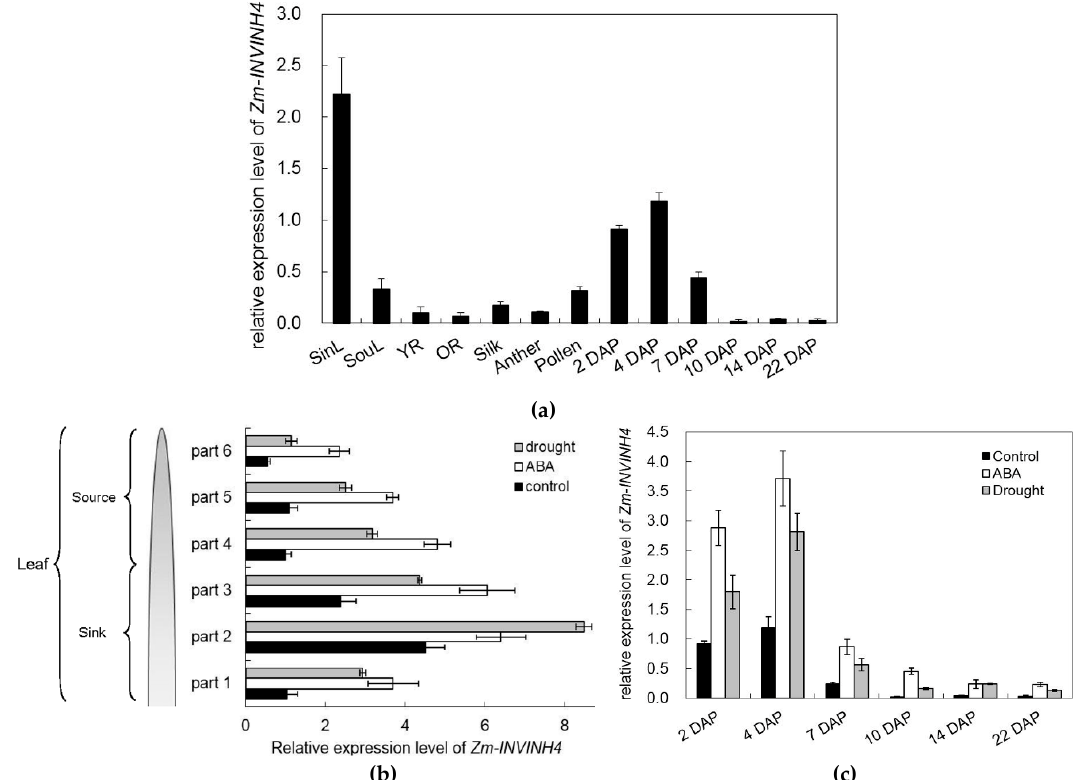
Figure 7. ( a ) Relative expression level of Zm-INVINH4 in different tissues of Zea mays . ( b ) Relative expression level of Zm-INVINH4 in the source and sink part of the leaf under the drought or ABA treatment. ( c ) Relative expression level of Zm-INVINH4 in young kernels under the drought or ABA treatment. Sink part of leaf (SinL); source part of leaf (SouL); young root (YR); old root (OR); day after pollination (DAP).